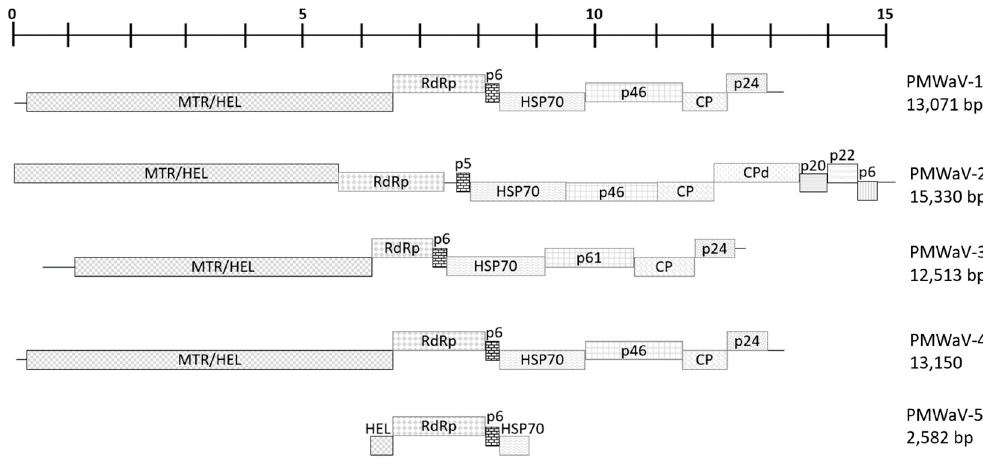
Figure 5. Genome organization of PMWaV-1, PMWaV-2, PMWaV-3, PMWaV-4, and PMWaV-5.